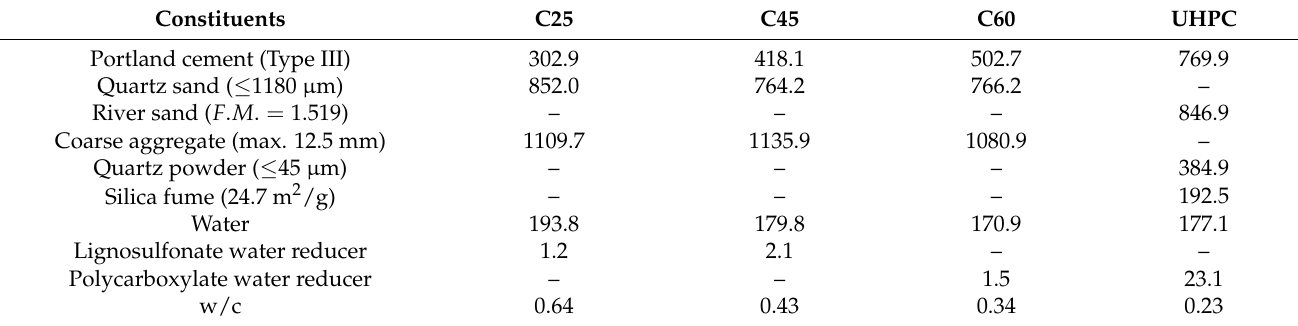
Table 1. Constituent of concretes and UHPC (kg/m 3